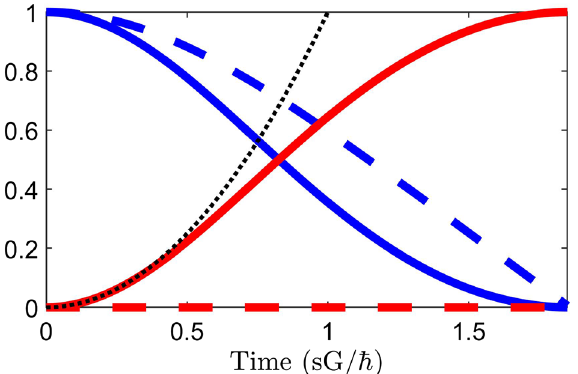
Figure 2. Full evolution of operators in a one-photon spontaneous Raman scattering process. Blue curves correspond to pump operators, while red curves correspond to Stokes operators. Solid curves correspond to ̂ a † 𝐤 a 𝐤 , while dotted curves correspond to fields ̂ a 𝐤 . Curves corresponding to ̂𝜎 intensities ̂ ̂ a † s a a a † of s , respectively. The dotted black curve corresponds to the perturbative analytical solution for p and p in Eq. (27). Here, the two-photon detuning Δ = 0